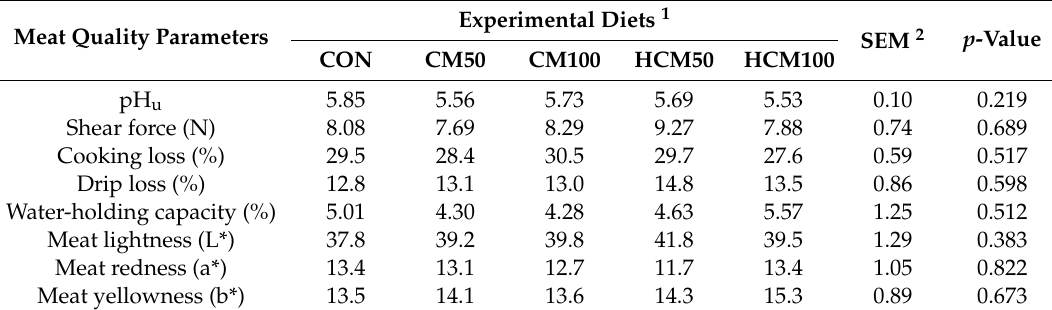
Table 7. Meat quality parameters of Meatmaster lambs that were fed untreated or heat-treated canola meal as a partial or complete replacement for soybean meal in finishing